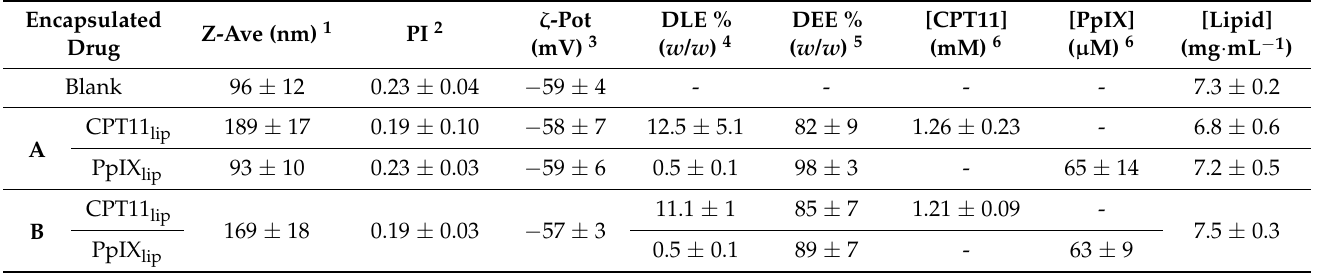
Table 1. Physicochemical characterization of